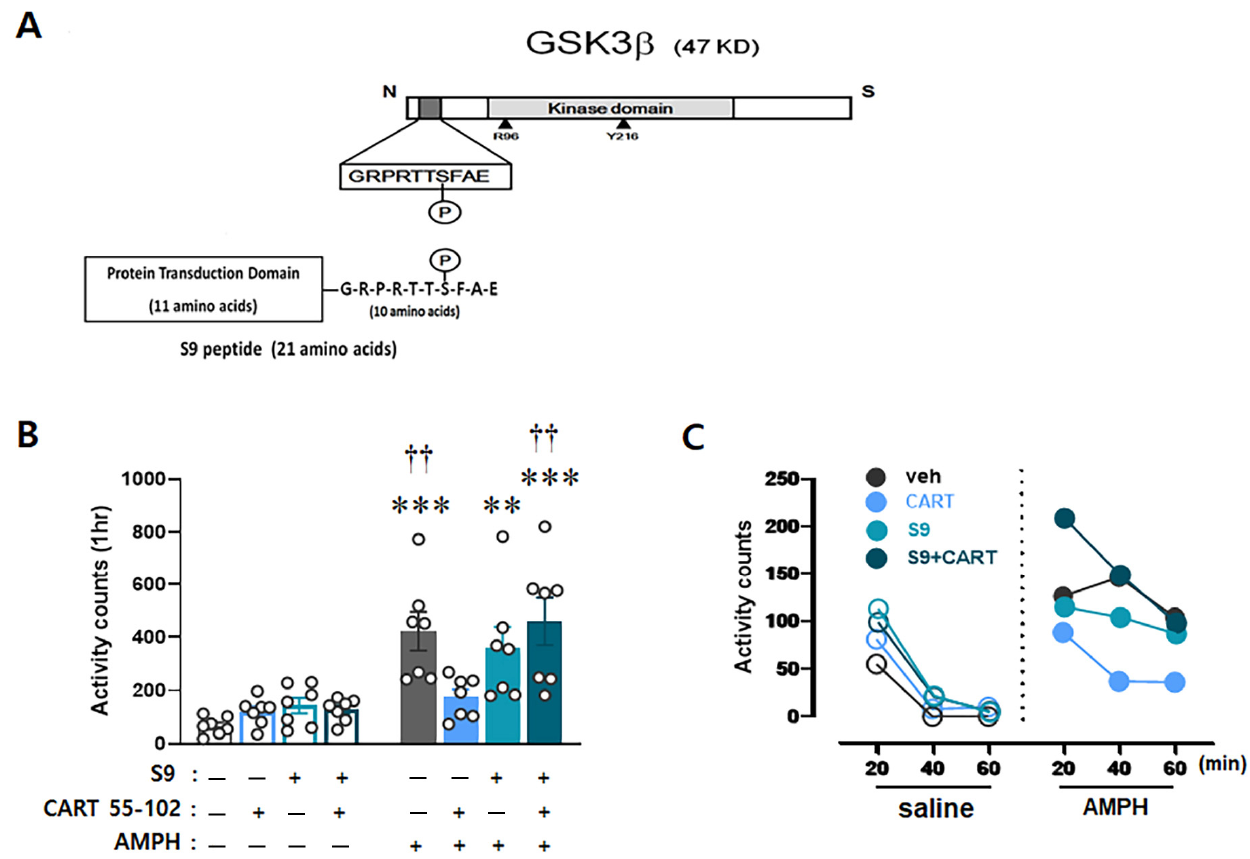
Figure 4. Interruption of Akt-GSK3 β signaling in the NAcc core abolishes inhibitory effects of CART peptide 55–102 on AMPH-induced locomotor activity. ( A ) A diagram showing the S9 peptide with short amino acid sequences competitive against a phosphorylation site at serine 9 of endogenous GSK3 β . ( B ) Data are shown as group mean (+S.E.M.) total locomotor activity counts observed dur-